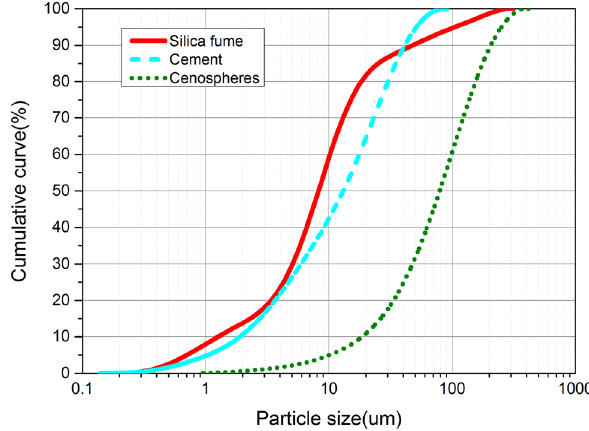
Figure 1: Particle size distribution of